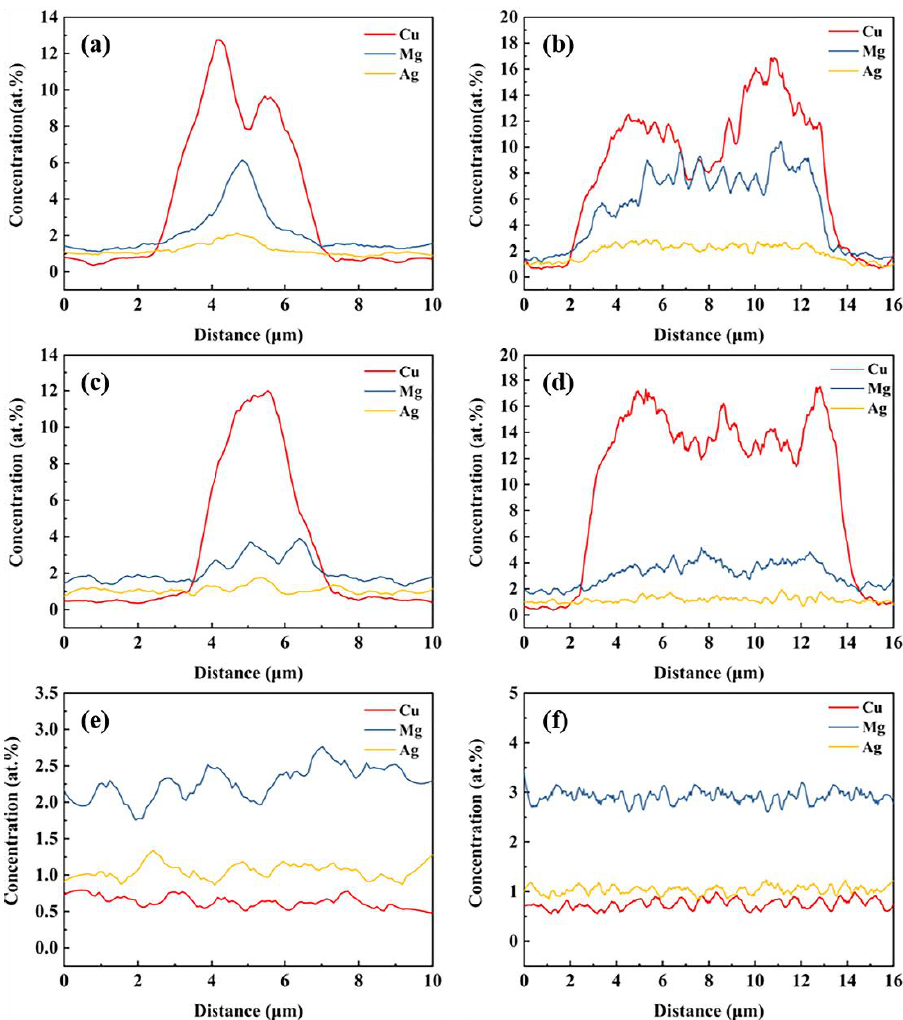
Figure 12. Elemental distributions along L1 ( a , c , e ) and L2 ( b , d , f ) at 400 °C ( a , b ), 450 °C ( c , d ) and 500 °C ( e , f ). Table 3. Effect of Cu/Mg ratio on the dissolution temperature of S phase. Cu/(wt.